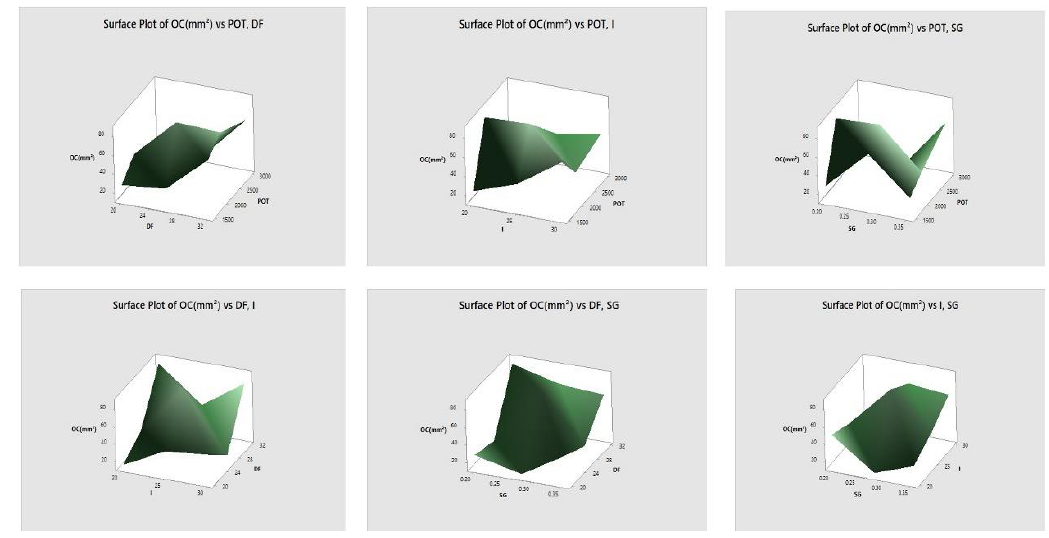
Fig. 10. Surface plot for the results of over